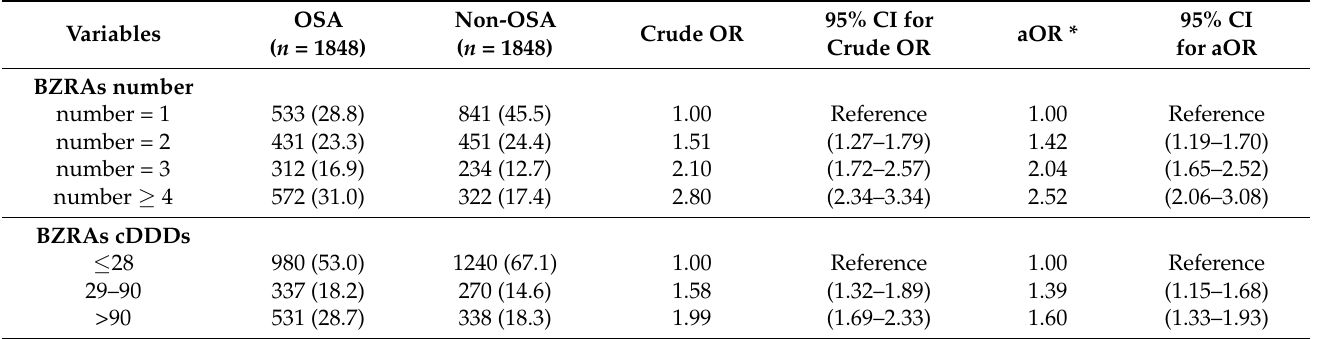
Table 3. Association between several kinds and dosages of BZRAs and risk of OSA development ( n = 3696).